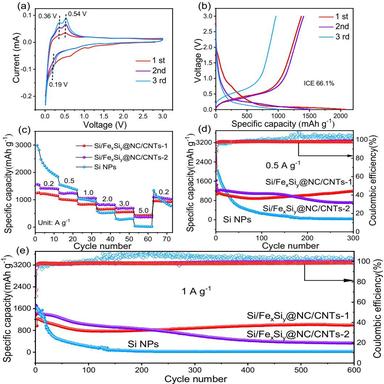
Electrochemical performance in half cell: (a) The first three CV curves of Si/FexSiy@NC/CNTs-1; (b) The first three discharge/charge curves of Si/FexSiy@NC/CNTs-1; (c) Rate capability of all samples; (d) Cycling performance at 0.5 A g1 ; (e) Long-term cycling performance at 1.0 A g1 .